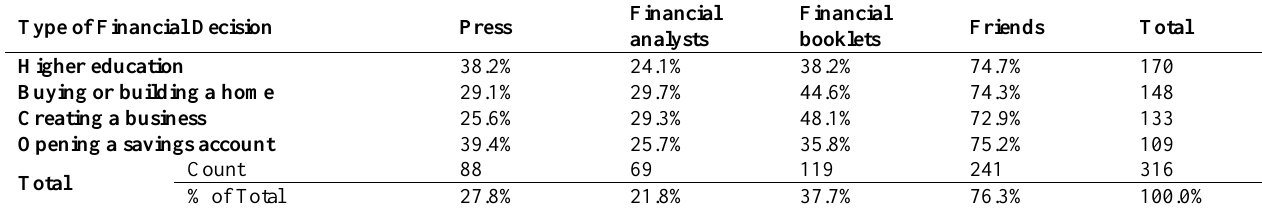
Table 4: Sources of information used for decision